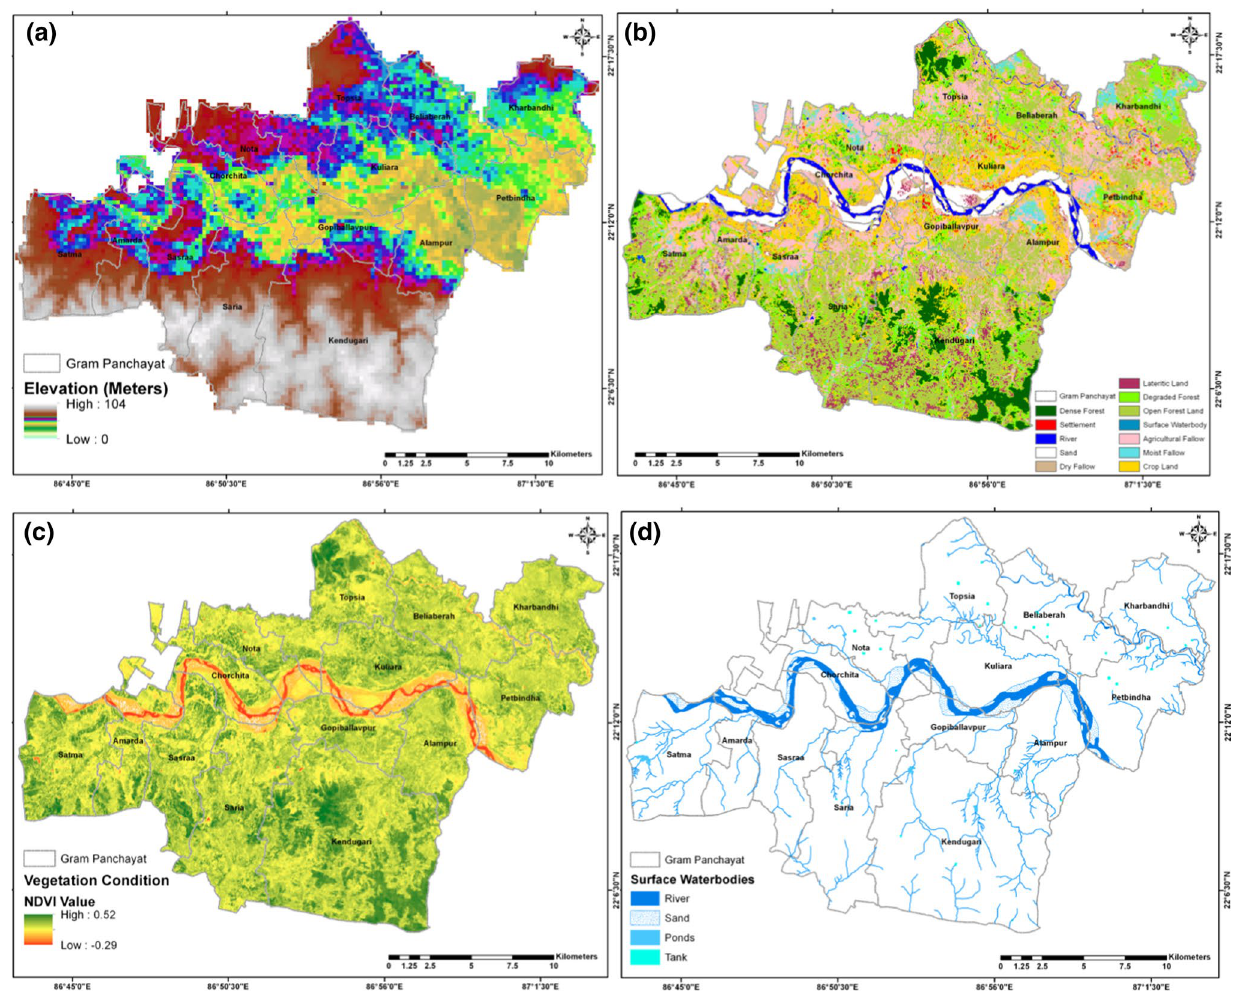
istics d surface water